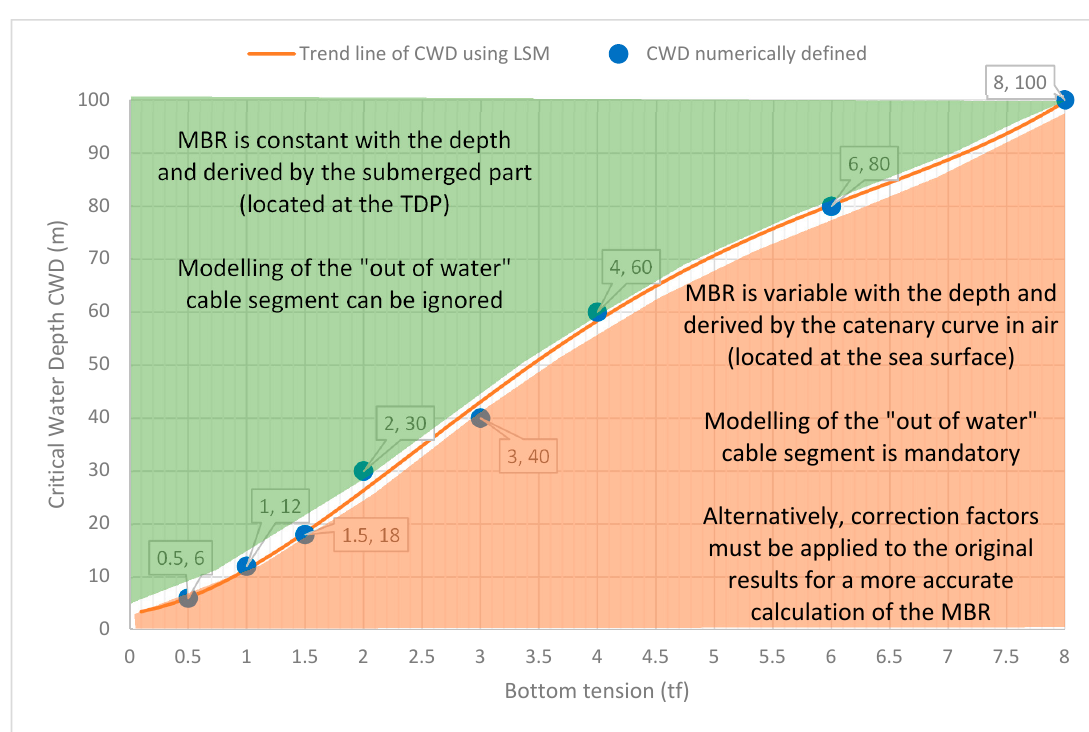
Figure 9. Critical water depth (CWD) for various bottom tension values.